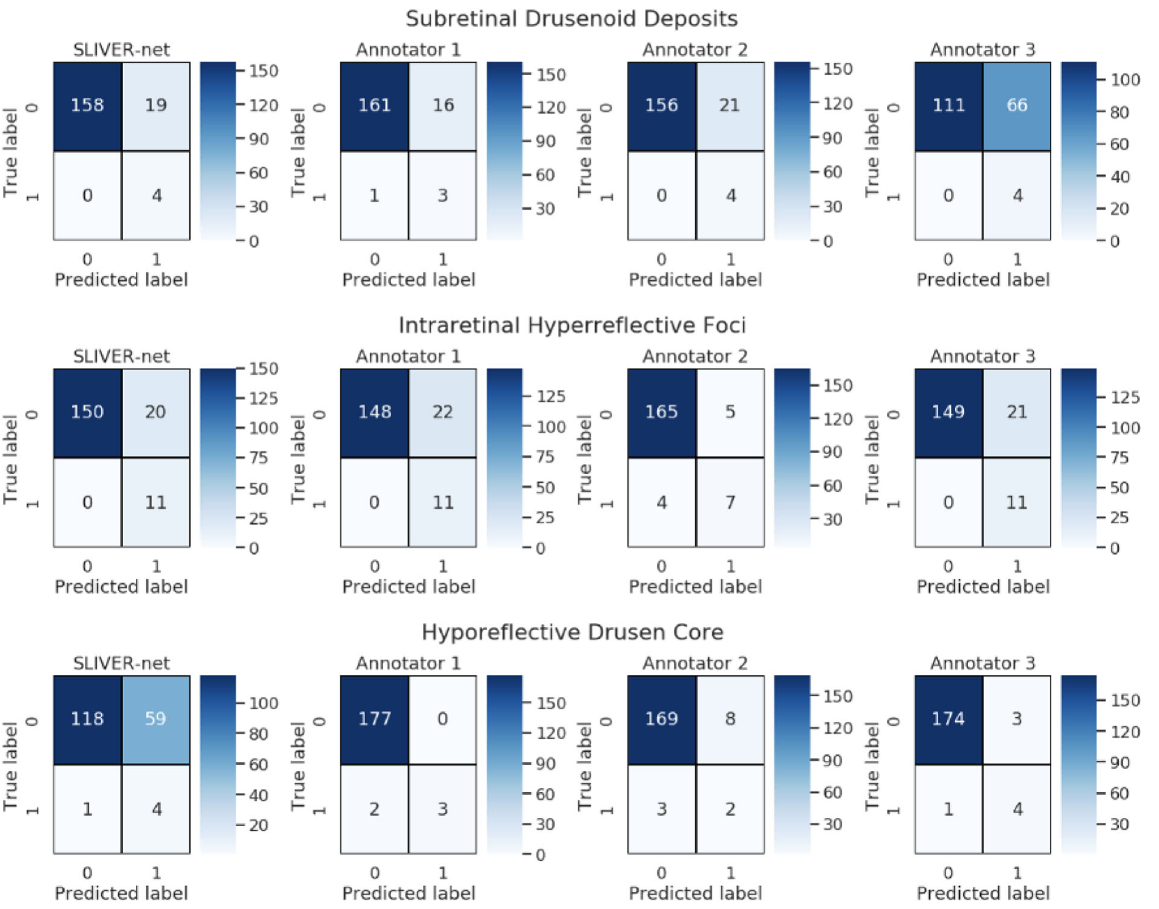
Fig. 3 Confusion matrices for SLIVER-net and the three retinal specialist annotators. 100 of the 390 test set patients were selected for comparison with clinician performance. The remaining 290 patients were used to compute the SLIVER-net threshold, which was selected to match the mean sensitivity of the annotators. For Subretinal Drusenoid Deposits and Intraretinal HRF, SLIVER-net displays a similar sensitivity to clinicians while operating at fewer false